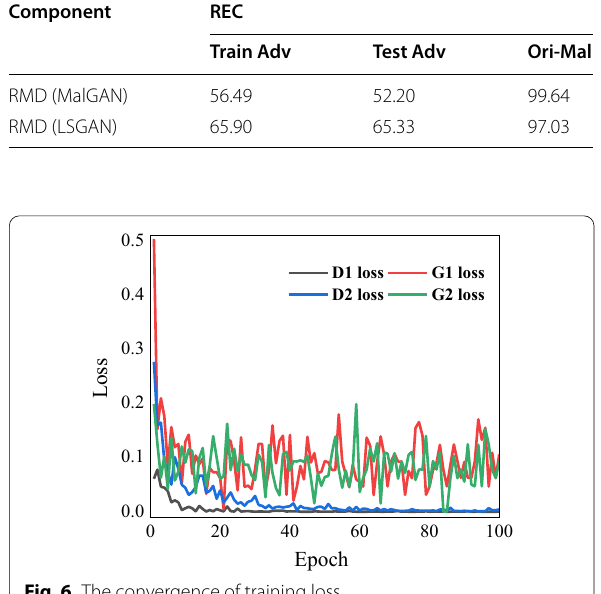
Fig. 6 The convergence of training loss